Question: Which visualization type does this figure use?
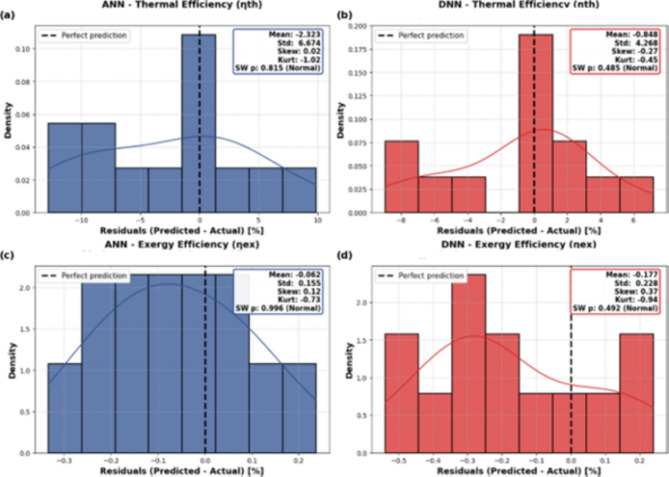
Answer: histogram